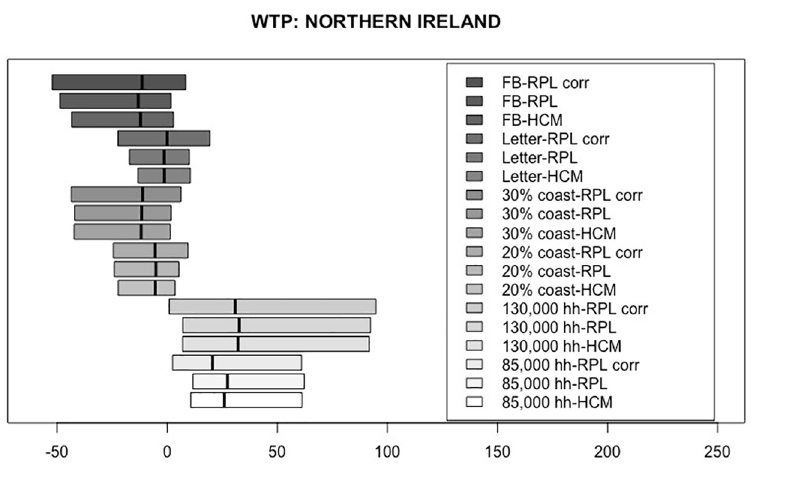
Fig 4. Distribution of WTP measures for Northern